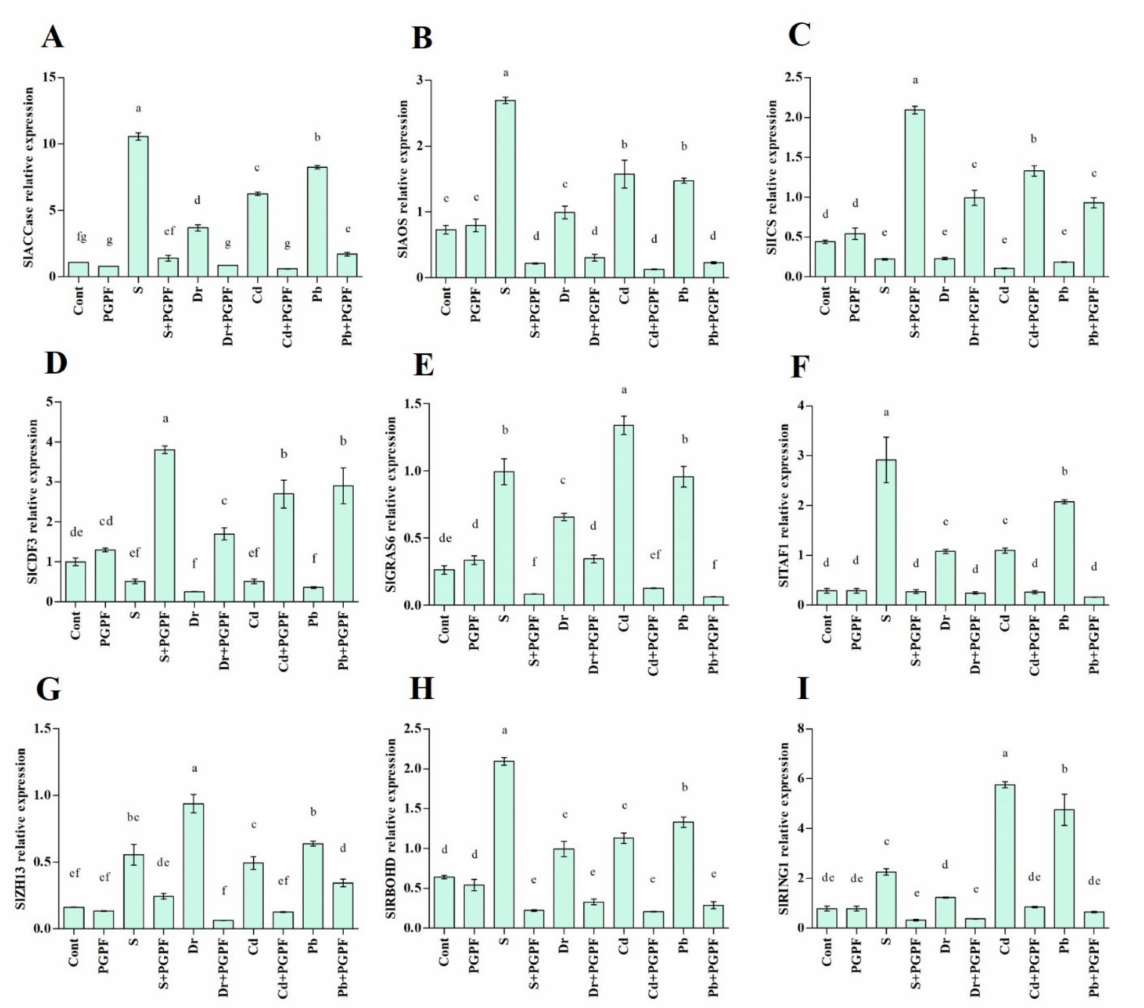
Figure 10. Real-time expression analysis of ( A ) SlACCase , ( B ) SlAOS , ( C ) SlICS , ( D ) SlCDF3 , ( E ) SlGRAS6 , ( F ) SlTAF1 , ( G ) SlZH13 , ( H ) SlRBOHD , and ( I ) SlRING1 in leaves of tomato plants grown under normal and stress conditions and inoculated with PGPF for 10 days. Treatments: Cont (control), PGPF ( Cunninghamella bertholletiae ), S (1.5% sodium chloride), S (1.5% sodium chloride) + PGPF ( Cunninghamella bertholletiae ), Dr (25% polyethylene glycol), Dr (25% polyethylene glycol) + PGPF ( Cunninghamella bertholletiae ), Cd (3 mM cadmium), Cd (3 mM cadmium) + PGPF ( Cunninghamella bertholletiae ), Pb (3 mM lead), and Pb (3 mM lead) + PGPF ( Cunninghamella bertholletiae ). Values are shown as the means ± SD ( n = 5) and significant differences at p < 0.05 (Tukey test) are indicated by different lowercase letters above the